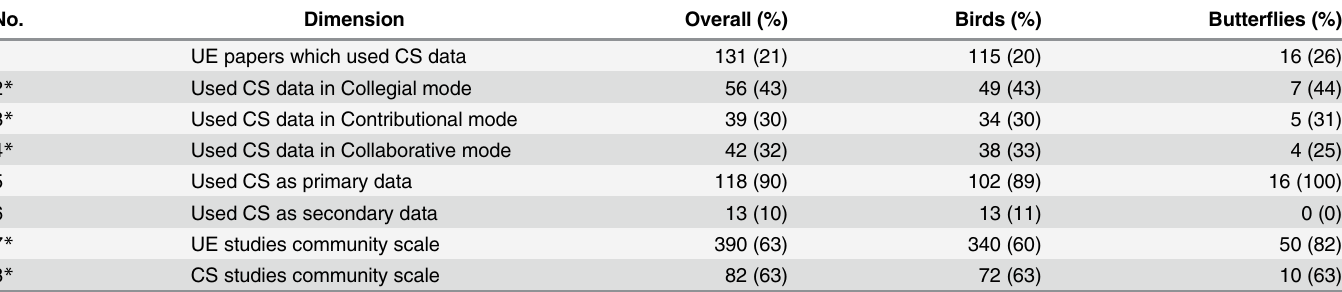
Table 4. Parameters of CS contributions to UE for birds and butterflies combined (summed total, not weighted total) and compared for birds and butterflies. These are presented as the number of studies tagged in each category, followed by its proportional representation in the literature as a rounded percentage of either the total number of UE studies (rows 1, 7 – 8) or the total number of CS studies (rows 2 – 6). The tags applied for the rows marked with asterisks were not mutually exclusive; hence the percentages do not necessarily tally to 100. No.